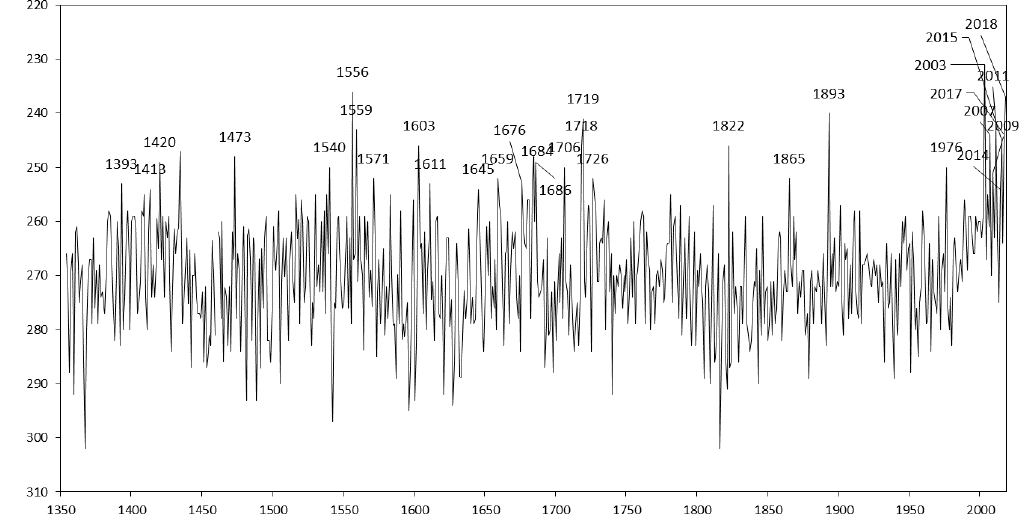
Figure 10. Beaune GHD time series (1354–2018) with an indication of most of the 5% earliest